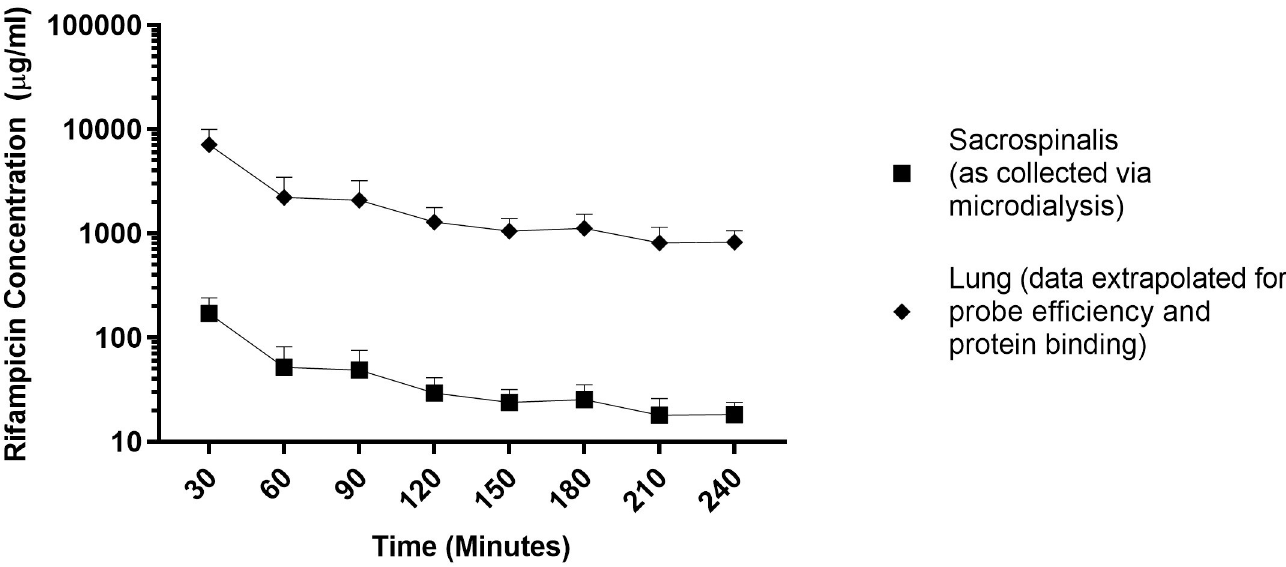
Fig 3. A comparison between rifampicin concentrations measured in the sacrospinalis and lung; lung concentrations were estimated from rifampicin concentrations measured via microdialysis of the sacrospinalis. Squares represent mean unbound rifampicin concentrations as recovered from the sacrospinalis via microdialysis (21% probe efficiency), diamonds are the mean total rifampicin concentrations in the lung as calculated by the equation shown in Fig 1 and corrected for 69% tissue protein binding and probe efficiency (21 ± 9%). Error bars represent standard deviation.